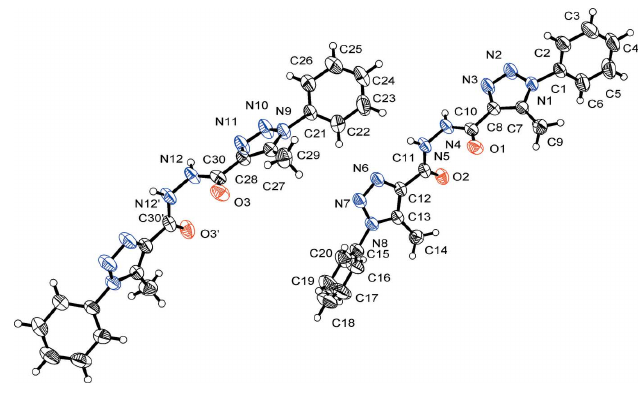
Figure 1 The molecular structure showing 50% displacement ellipsoids. Primed and unlabelled atoms are generated by the symmetry operation 1 (cid:3) x , y , 1 (cid:3) z 2